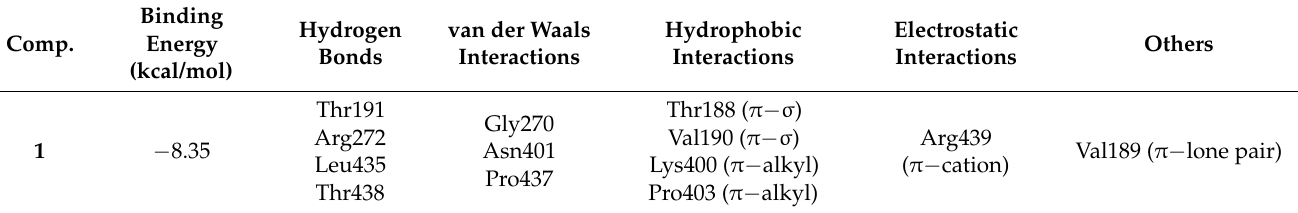
Table 2. Docking energies and binding site interactions of compound 1 with the β -glucuronidase